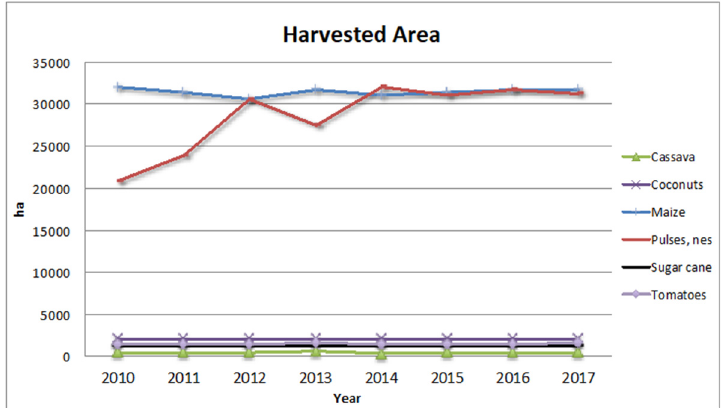
Figure 5. Harvest area (ha) of the top six agriculture commodities in Cabo Verde, from 2010 to 2017. Source: